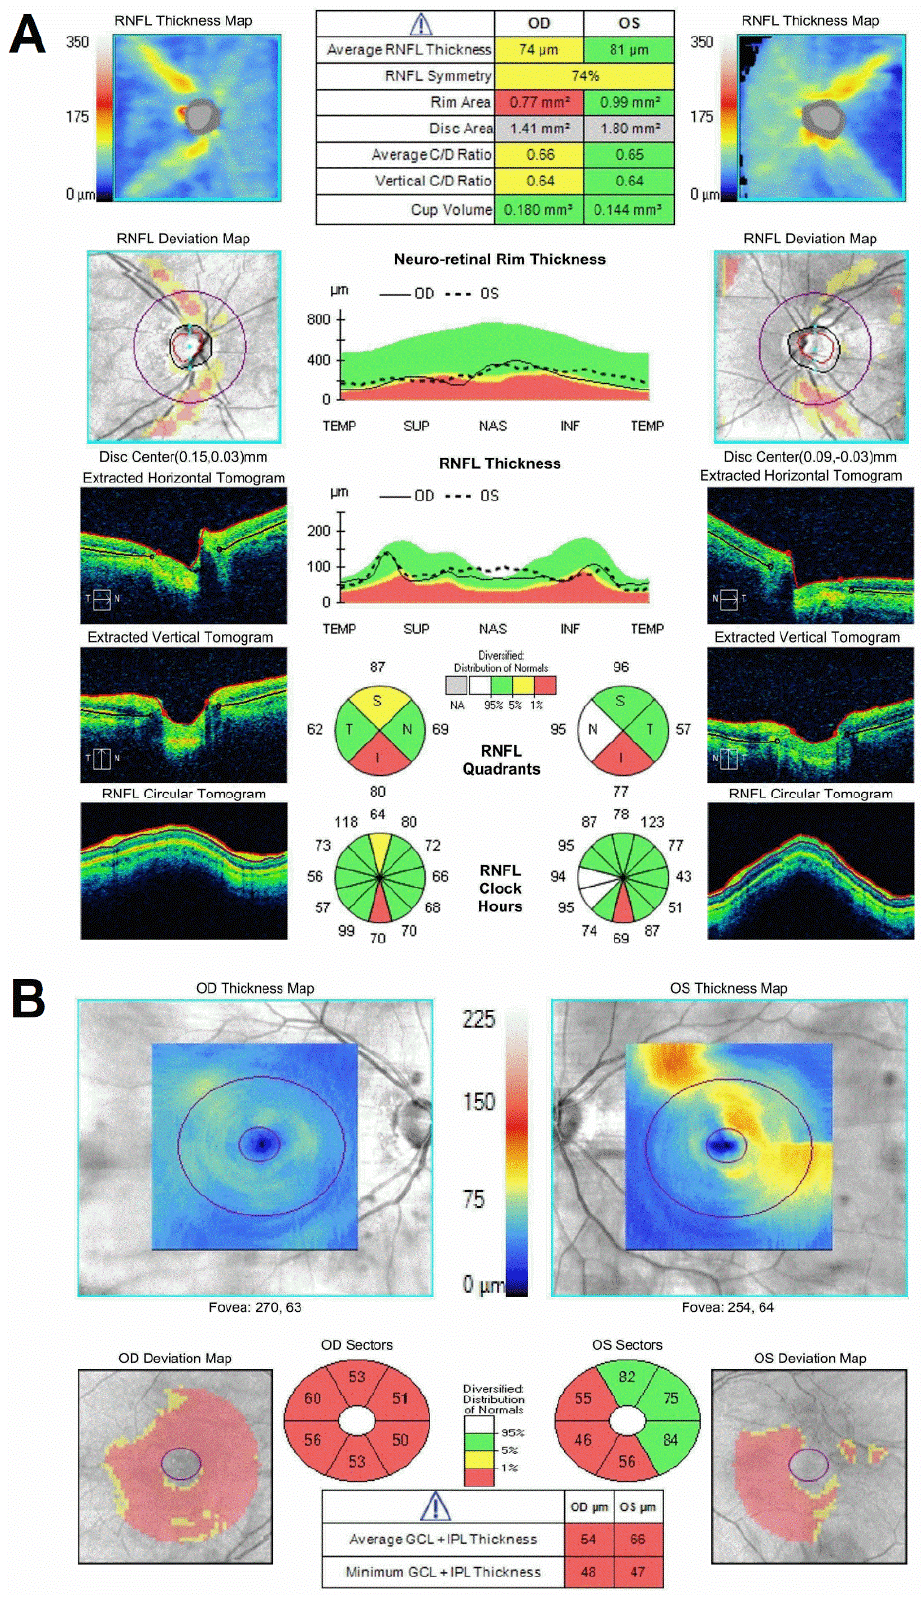
Figure 2. Optic nerve and retinal photography by OCT demonstrating vertical optic nerve atrophy with associated thinning in the retinal ganglion cell layer. SD − OCT of the peripapillary and central retina in the WDR36 -positive patient. ( A ) SD − OCT of the peripapillary retina in the patient. Sides (left and right columns) are plots of the topography of the peripapillary RNFL thickness as raw thickness values (top row) and as deviation maps (second row) compared to a normative database